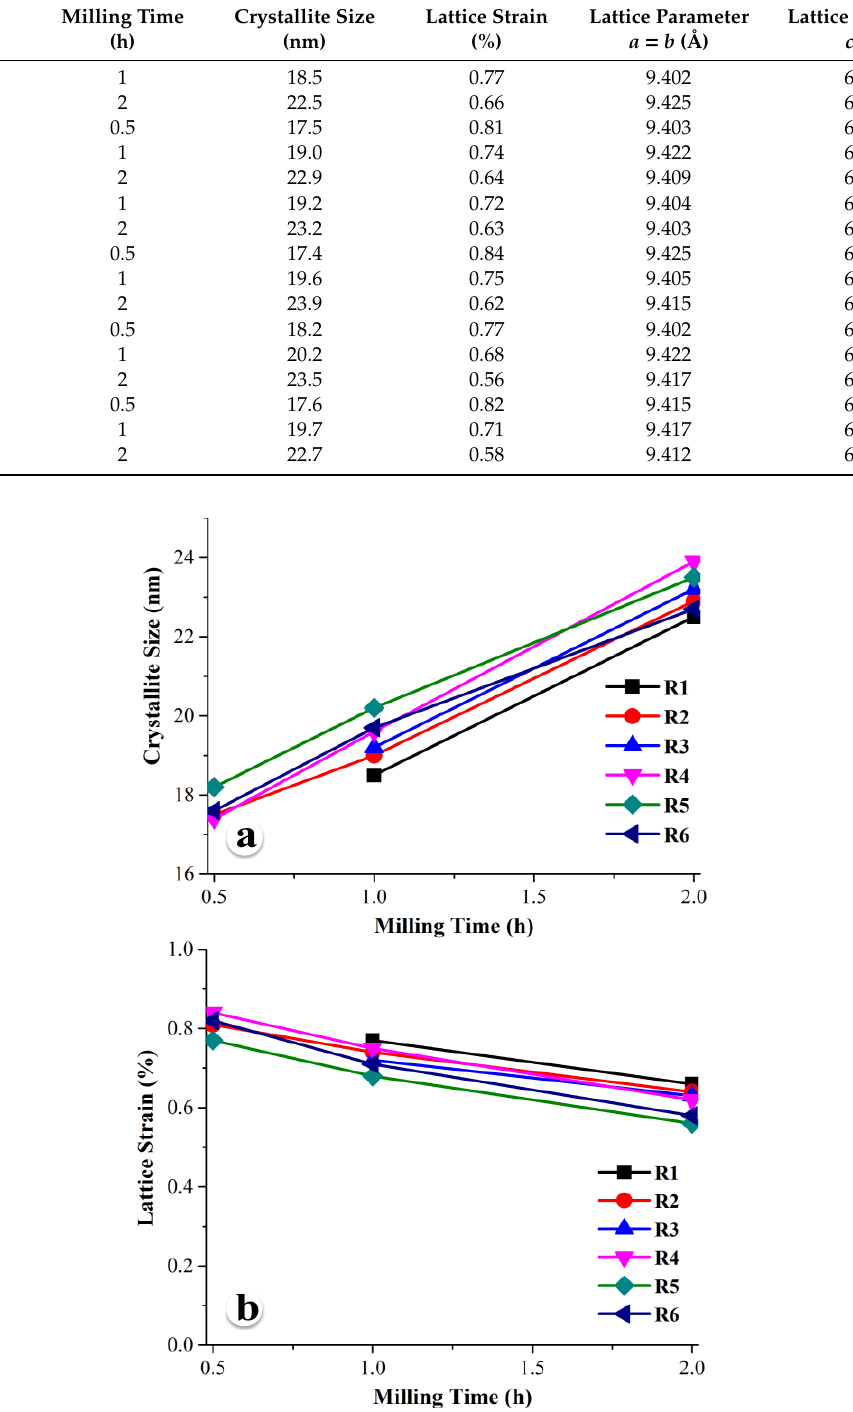
Figure 2. ( a ) Crystallite size and ( b ) lattice strain of the Hydroxyapatite (HA) crystal formed in six different powder mixtures after 30 min, 1 h, and 2 h of ball milling.